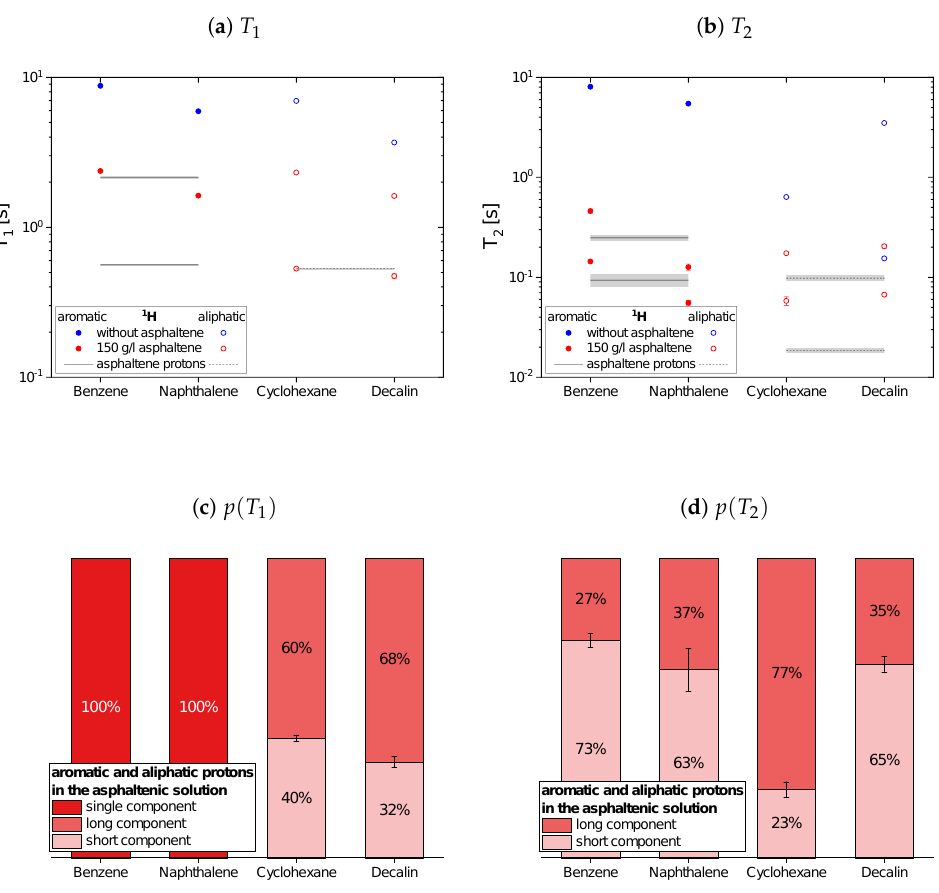
Figure 9. Top: Longitudinal ( a ) and transverse ( b ) relaxation time constants of the aromatic and aliphatic protons of cyclic maltenes in the asphaltene-free and the asphaltenic solution. The black lines indicate the T 1 and T 2 constants of the asphaltene protons in a benzene-d 6 solution. Bottom: Relative weight of the T 1 ( c ) and T 2 ( d ) components of the maltenes’ protons in the asphaltenic solution. The x-axis distinguishes the different solutions, consisting of 5vol% of the specified maltene and 95vol% benzene-d 6 without or with 150g/L